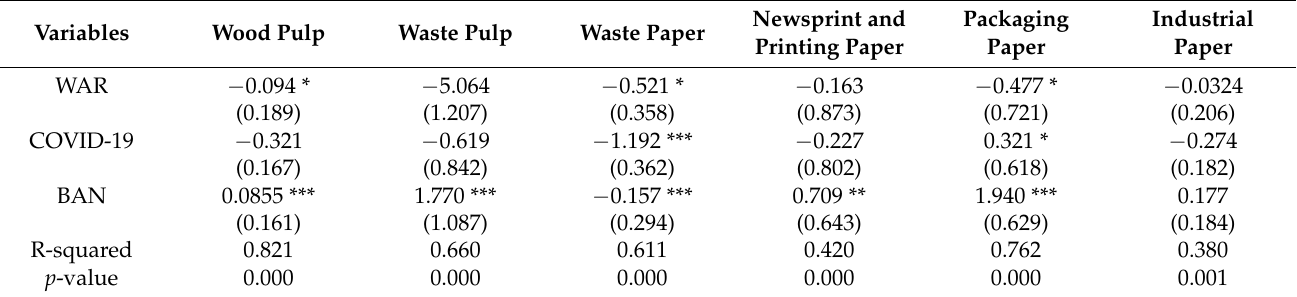
Table 5. Results of robustness tests.